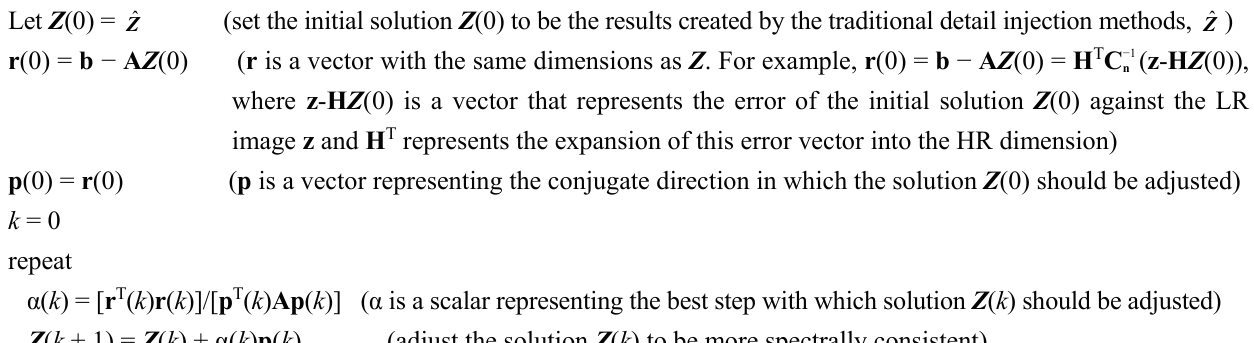
Algorithm 1 . Conjugate gradient search algorithm to avoid large matrix